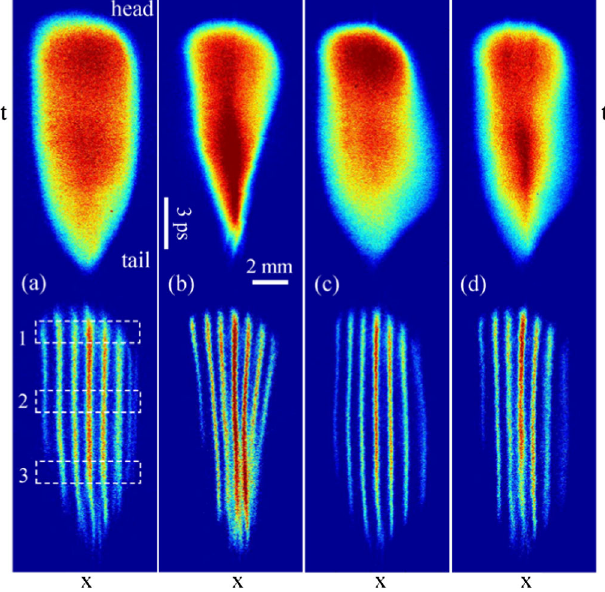
FIG. 4. Time-resolved measurements of beam (top) and beam- lets (bottom) distribution on screen P1. Four situations are shown: (a) with two CS widely open; (b) with downstream CS gap set at 3.2 mm; (c) with upstream CS gap set at 3.2 mm; (d) with both CS both gaps set at 3.2 mm. The dashed squares in (a) indicates the three representative slices used for analysis of emittance and phase space in Figs. 5 and 6.